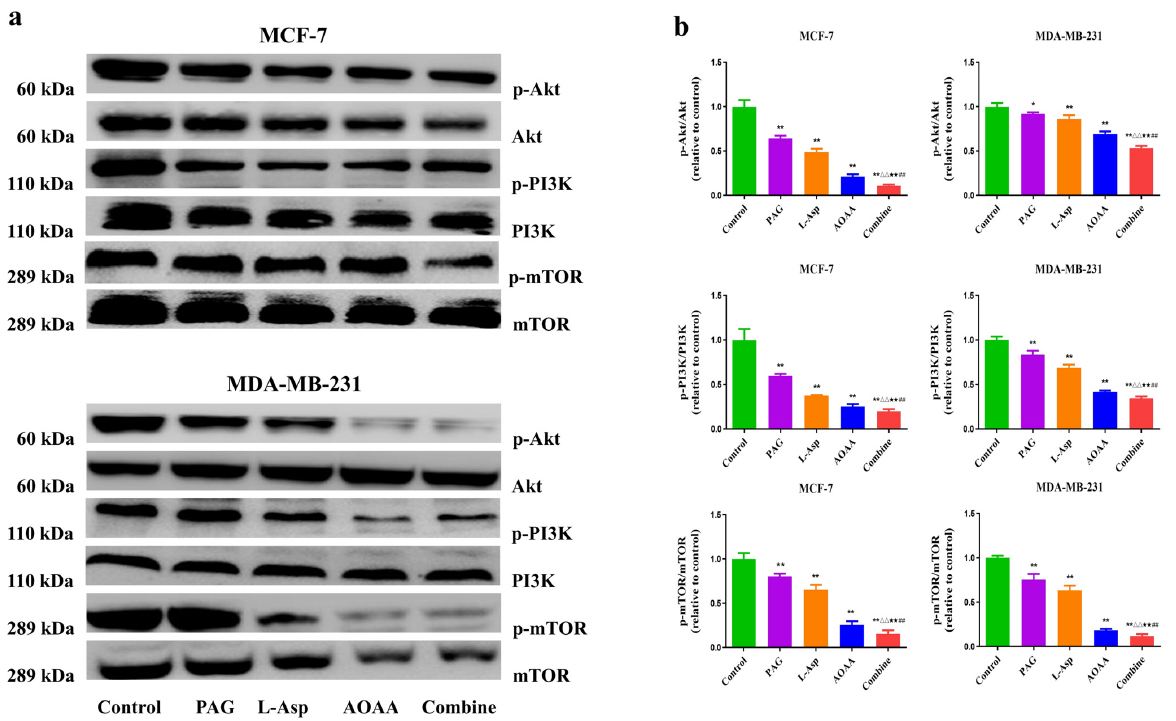
Figure 5. Effects of PAG, AOAA, and L ‐ Asp on the PI3K/AKT/mTOR signaling pathway in human BC cells. ( a ) The expression levels of p ‐ PI3K, p ‐ AKT, and p ‐ mTOR were detected by Western blot. ( b ) Densitometric quantification was performed, normalized to the level of respective non ‐ phosphorylated candidate protein. The experiments were performed in triplicate. Data are presented as mean ± SEM. * p < 0.05, ** p < 0.01 compared with the control group; △ p < 0.05, △△ p < 0.01 compared with PAG group; ★ p < 0.05, ★★ p < 0.01 compared with AOAA group; ## p < 0.01 compared with L ‐ Asp group.